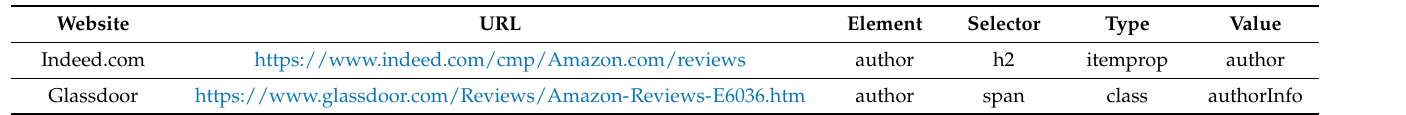
Figure 1. Process of web scraping (source: authors own study). Table 1. Metadata table.